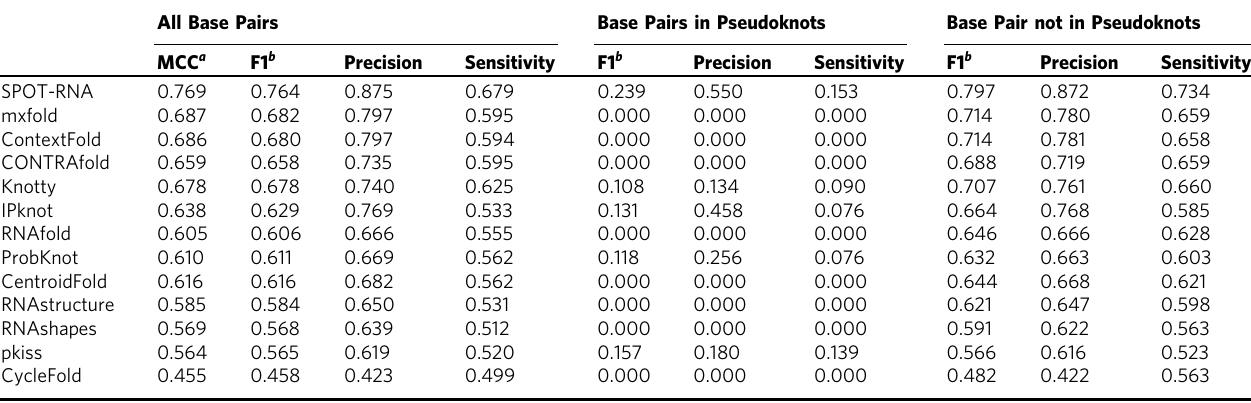
Table 3 Performance of all the predictors on 40 pseudoknot RNAs in the test set TS1. All Base Pairs Base Pairs in Pseudoknots Base Pair not in